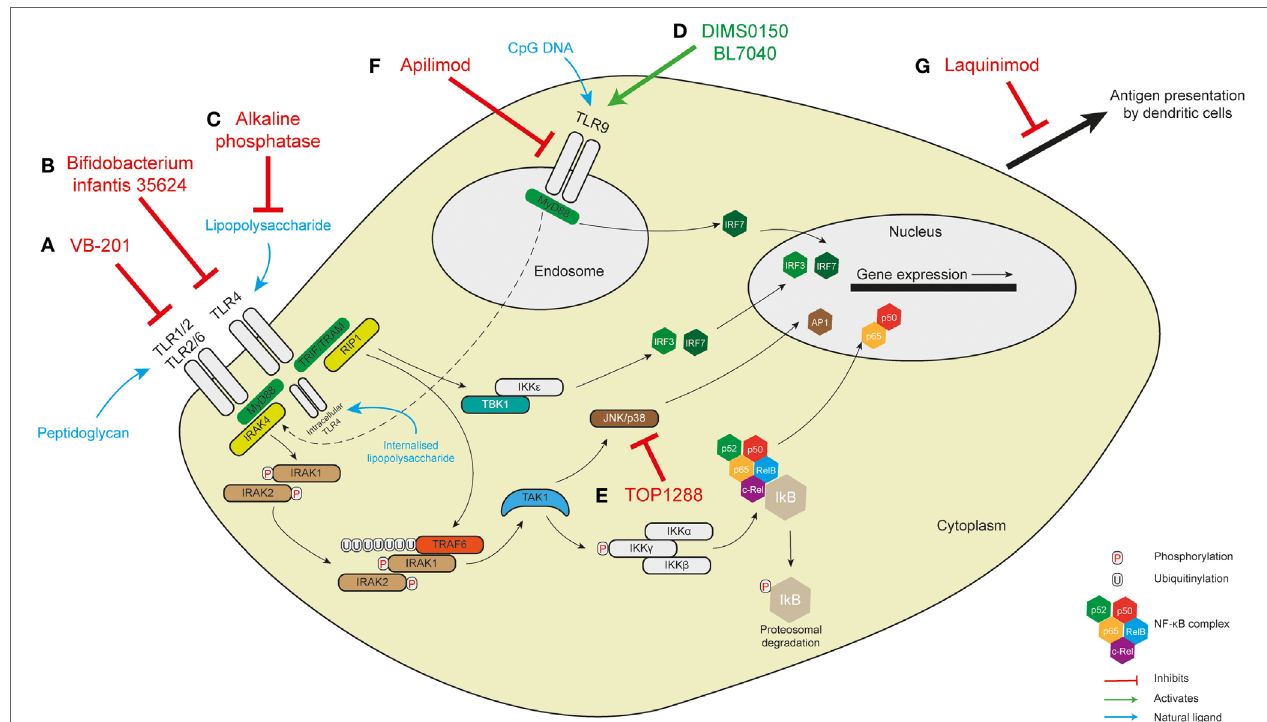
FiGURe 2 | Targeting pattern-recognition receptor signaling in human intestinal inflammation. (A) The small molecule VB-201 interferes with downstream signaling from TLR2 and has been trialed in ulcerative colitis. (B) Similarly, Bifidobacterium infantis 35624, which probably acts to interfere with the TLR4 signaling pathway, has been trialed in maintaining remission in ulcerative colitis. The results of these two trials are not known. TLR4 is found on the cell membrane in immune cells but in intestinal epithelial cells has been demonstrated intracellularly where it responds to internalized lipopolysaccharide. (C) Alkaline phosphatase detoxifies LPS to inhibit TLR4 signaling and has been shown to be of benefit in ulcerative colitis. It is not known whether it might interfere with intracellular TLR4. Similar benefits have been seen with the TLR9 agonists DIMS0150 and BL7040 (D) . (e) TOP1288, a narrow spectrum kinase inhibitor, has effects on p38, Src, Lck, and Syk to reduce colonic IL-6 and -8 in ulcerative colitis. (F) The exact role of apilimod in innate immune sensing is not well understood but there are effects on endosomal maturation and TLR9 sensing—this was not, however, effective in a trial in Crohn’s disease. (G) Laquinimod exerts some effects on antigen presentation by dendritic cells with some improvement in remission in Crohn’s